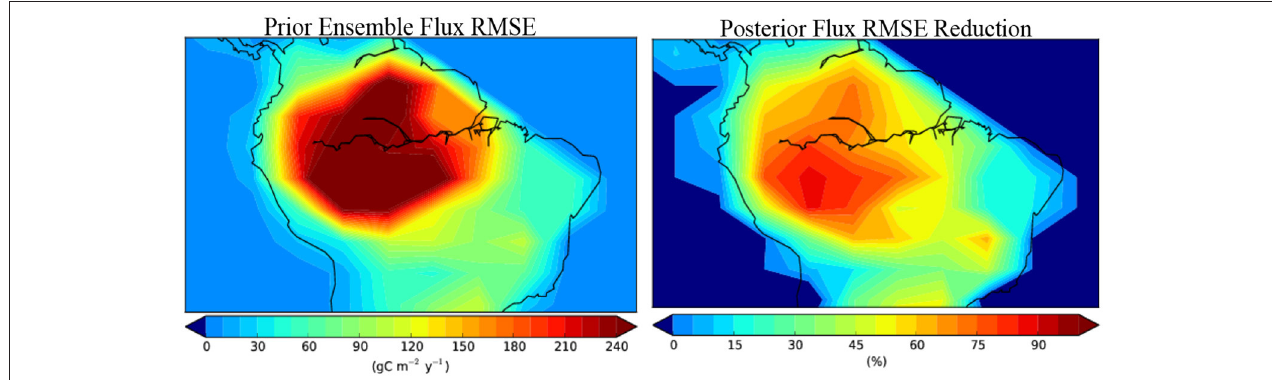
FIGURE 5 | (Left) Prior ensemble annual flux RMSE for the Amazon CO 2 OSSE, which represents a 5% underestimate of annual GPP relative to CASA-GFED. (Right) RMSE reduction after assimilating GeoCarb observations for a single year. This reduction leads to posterior errors of about 75 gC m − 2 y − 1 over the Amazon basin. Similar experiments with smaller prior mismatch led to a similar posterior RMSE (not shown), indicating the strong data constraint of GeoCarb